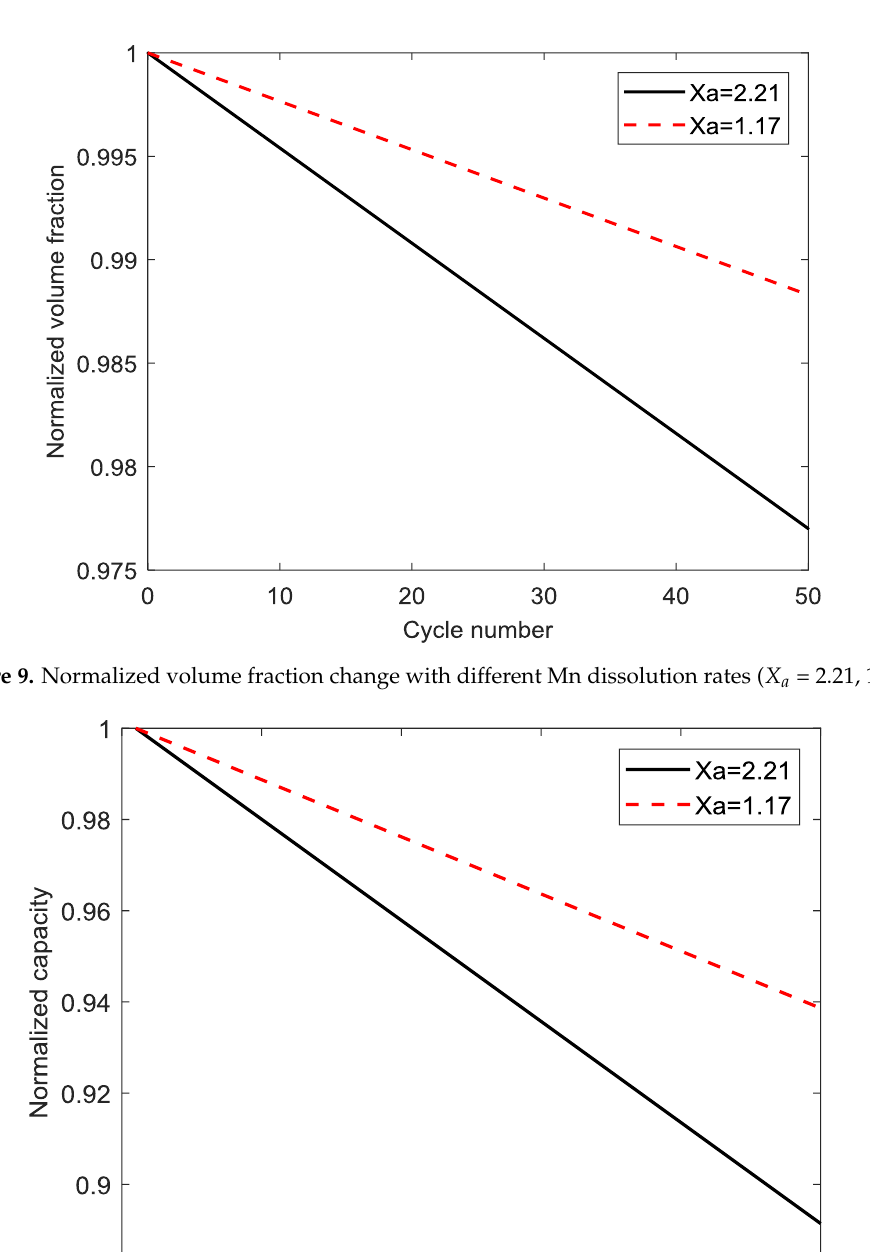
Figure 10. Normalized capacity with different Mn dissolution rates ( X a = 2.21,